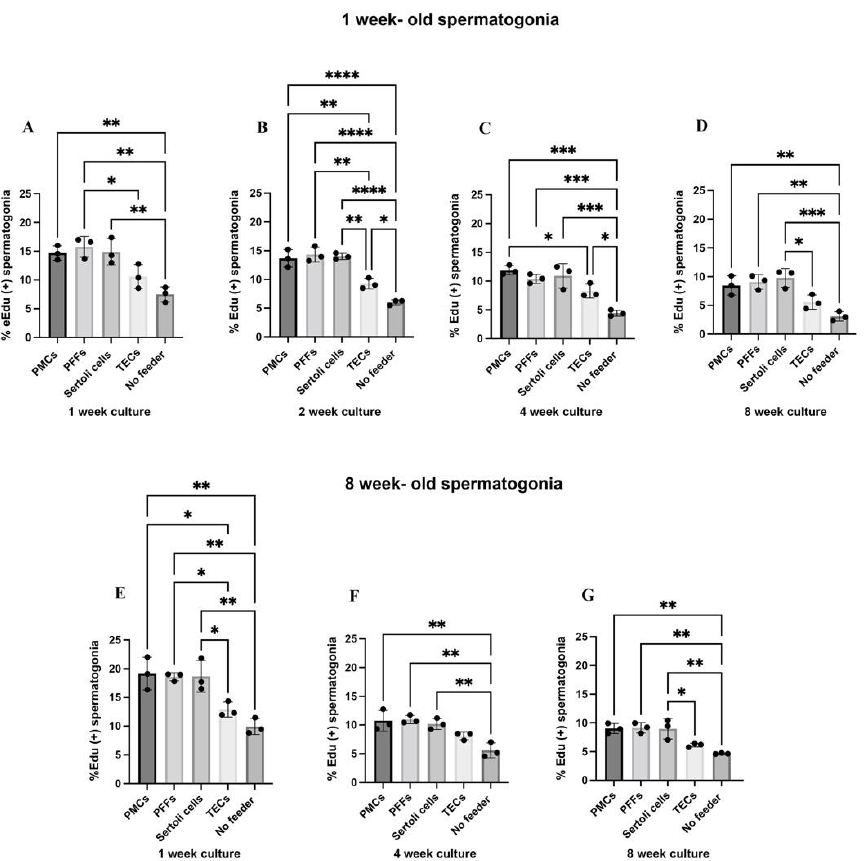
Figure 2. PMCs, PFFs, and Sertoli cells support higher rates of spermatogonial proliferation com- pared to TECs or no-feeder controls. Percent of UCH-L1 (+) spermatogonia from one-week-old por- cine testis that are also EdU (+), in co-culture conditions at one week ( A ), two weeks, ( B ), four weeks ( C ), and eight weeks ( D ) of culture. Percent of UCH-L1 (+) spermatogonia from eight-week-old por- cine testis that are also EdU (+), in co-culture conditions at one week ( E ), four weeks ( F ), and eight weeks ( G ) of culture. Data are presented as mean ± SD (n = 3). A p -value of <0.05 was considered significant (* p ≤ 0.05, ** p ≤ 0.01, *** p ≤ 0.001, **** p ≤